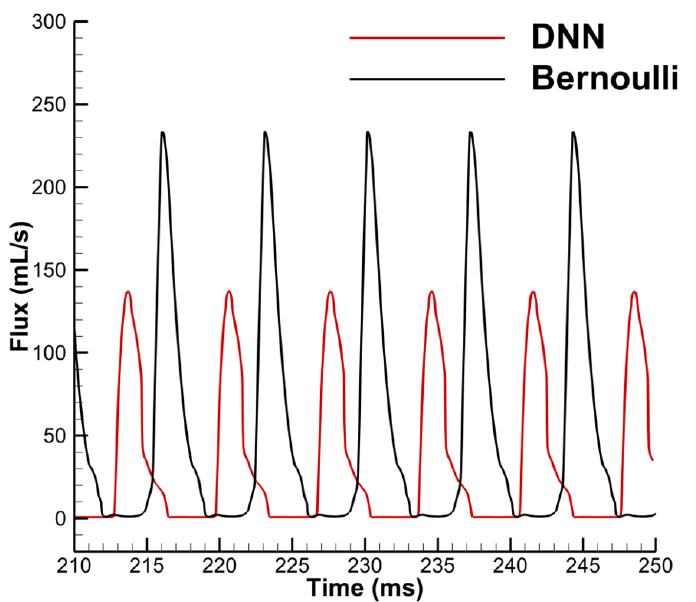
Figure 17. Comparison of the flow rate obtained by the DNN-Bernoulli and Bernoulli